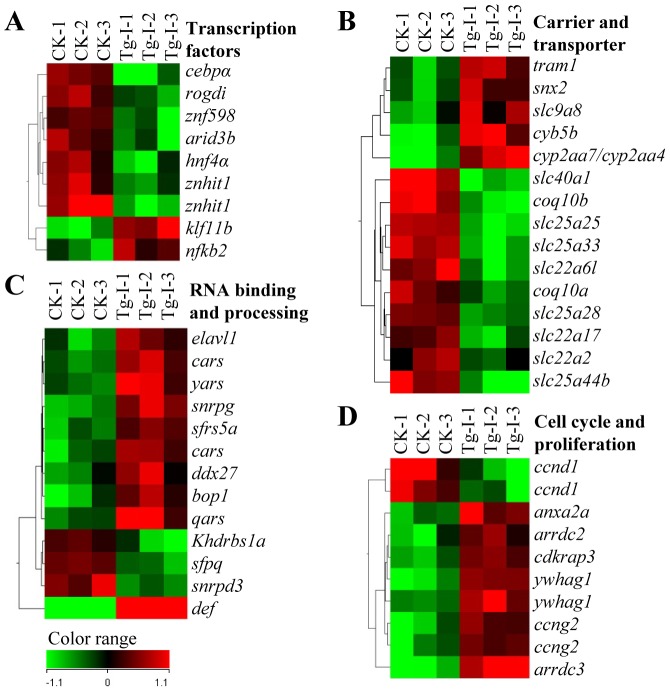
Expression of genes in specific functional pathways was altered in a coordinate way in the liver of Tg-I.(A–D) Expression of genes in categories for encoding transcription factors (A), carrier and transporter (B), RNA bidning and processing (C), and cell cycle and proliferation (D) were found to be coordinately regulated by Def over-expression. CK: wild type adult liver control.